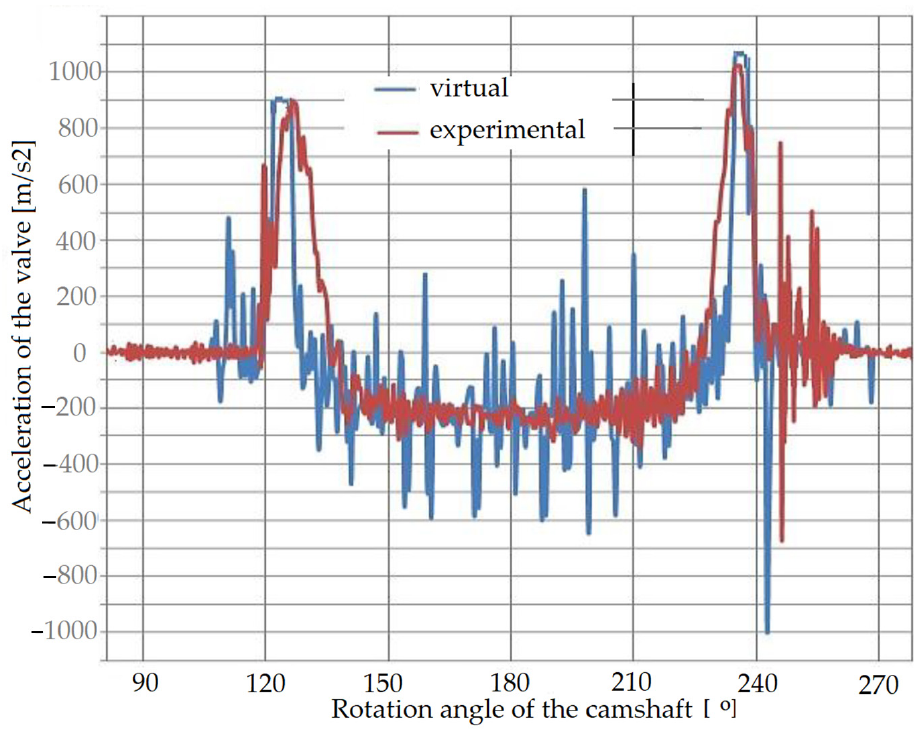
Figure 14. Valve acceleration for n AD = 1000 rpm.